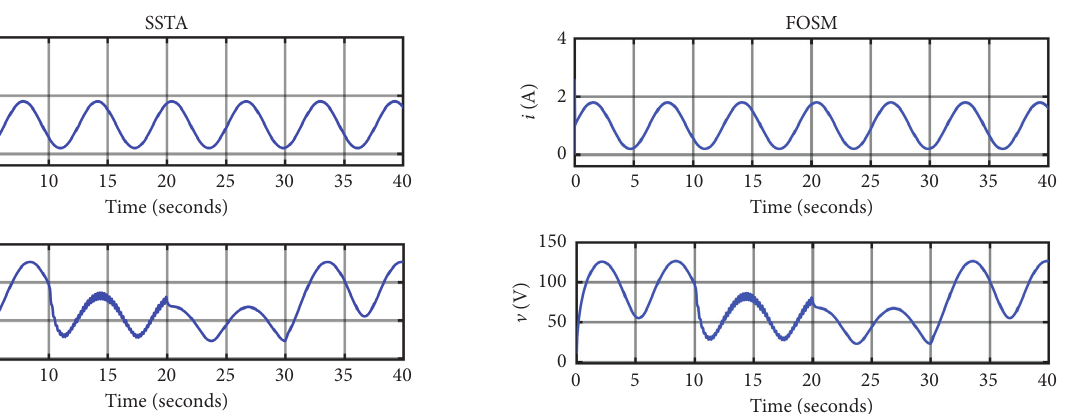
Figure 8: Boost current and voltage with the FOSM